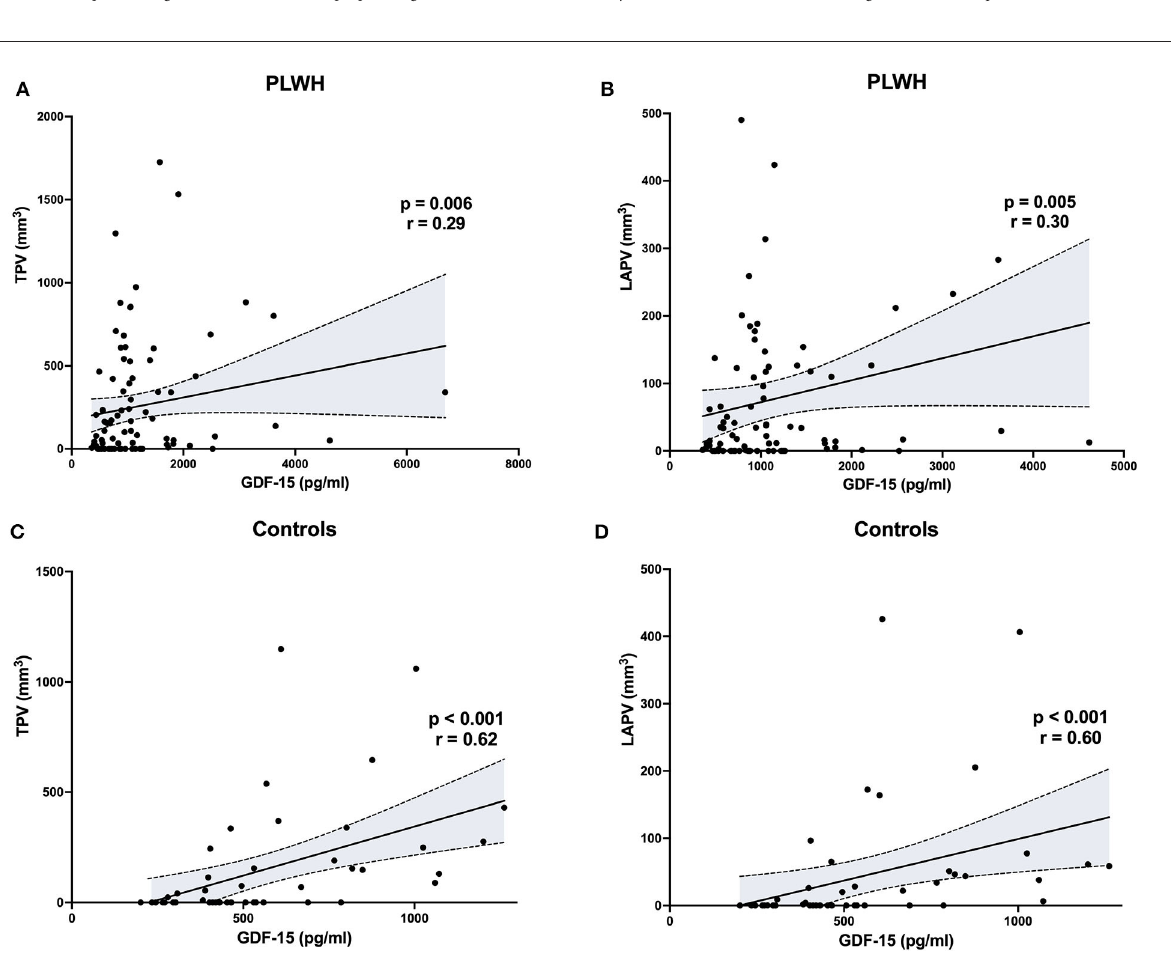
high levels of GDF-15 had significantly higher plaque volume than those with low GDF-15 levels ( p = 0.02). In contrast to PLWH, only the association of high GDF-15 levels and smoking